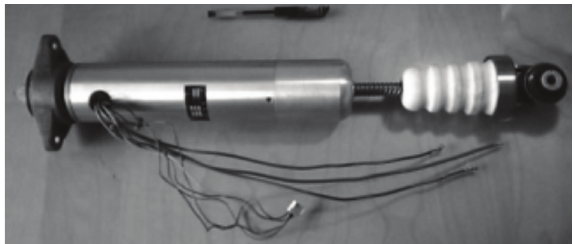
Figure 6: Ball screw type actuator.